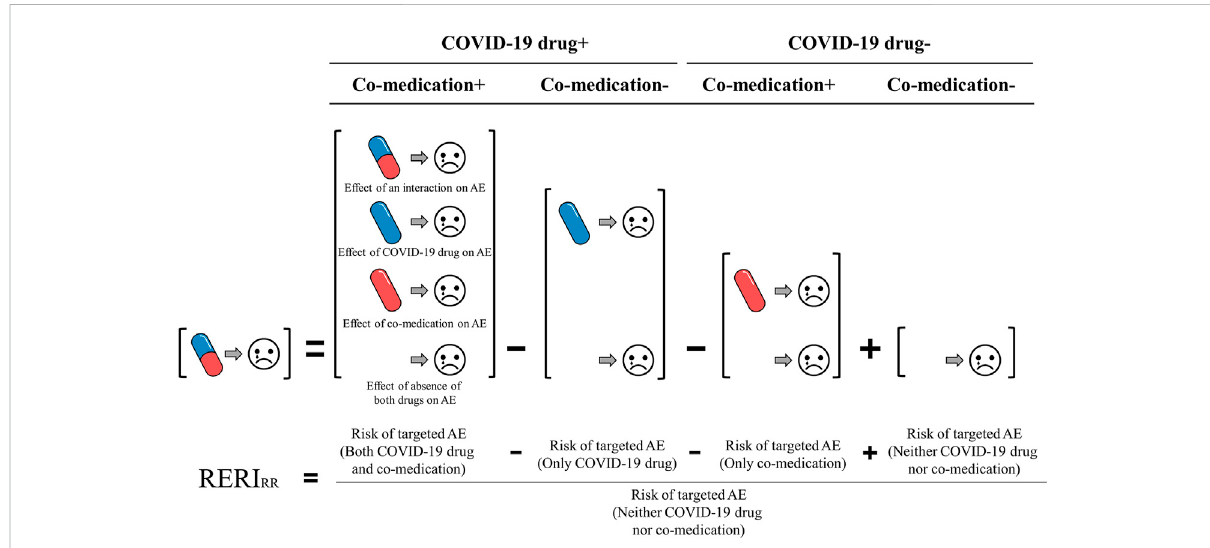
FIGURE 1 A measure of additive interaction between a COVID-19 drug and a co-medication on a targeted